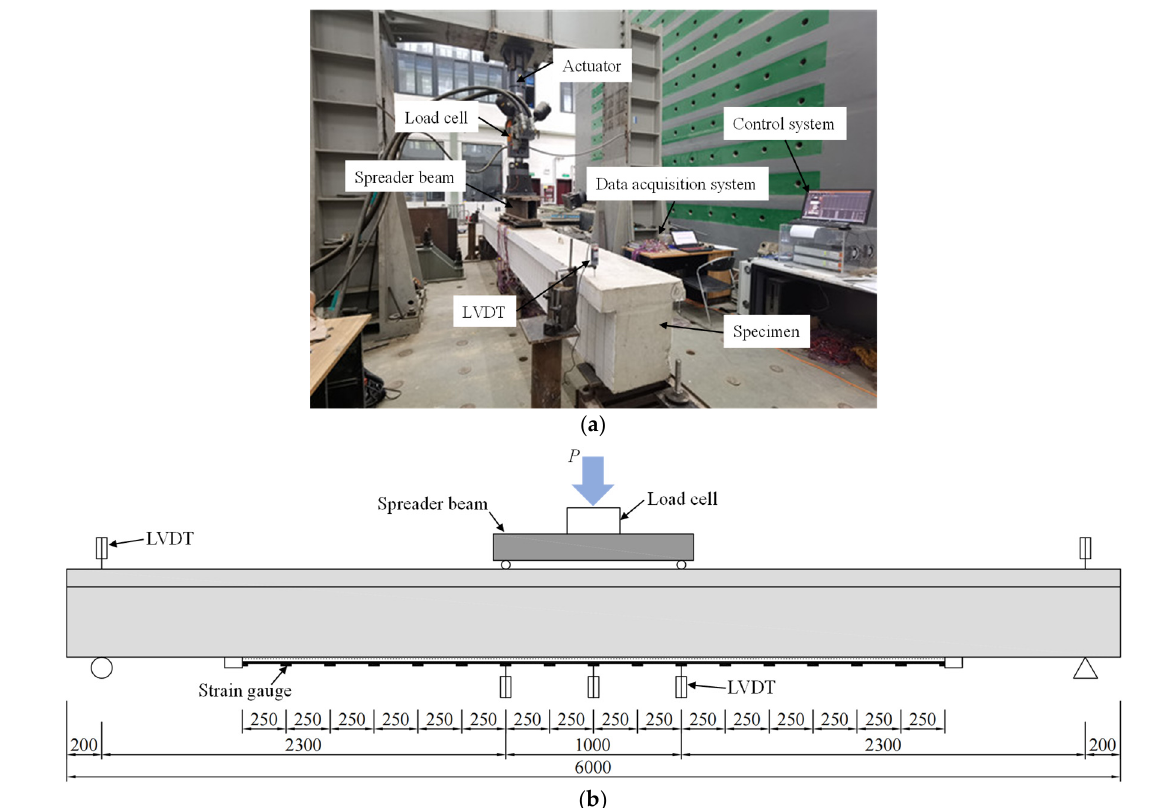
Figure 5. Test setup of the specimen: ( a ) loading photo and ( b ) schematic of loading and instruments (unit in mm).